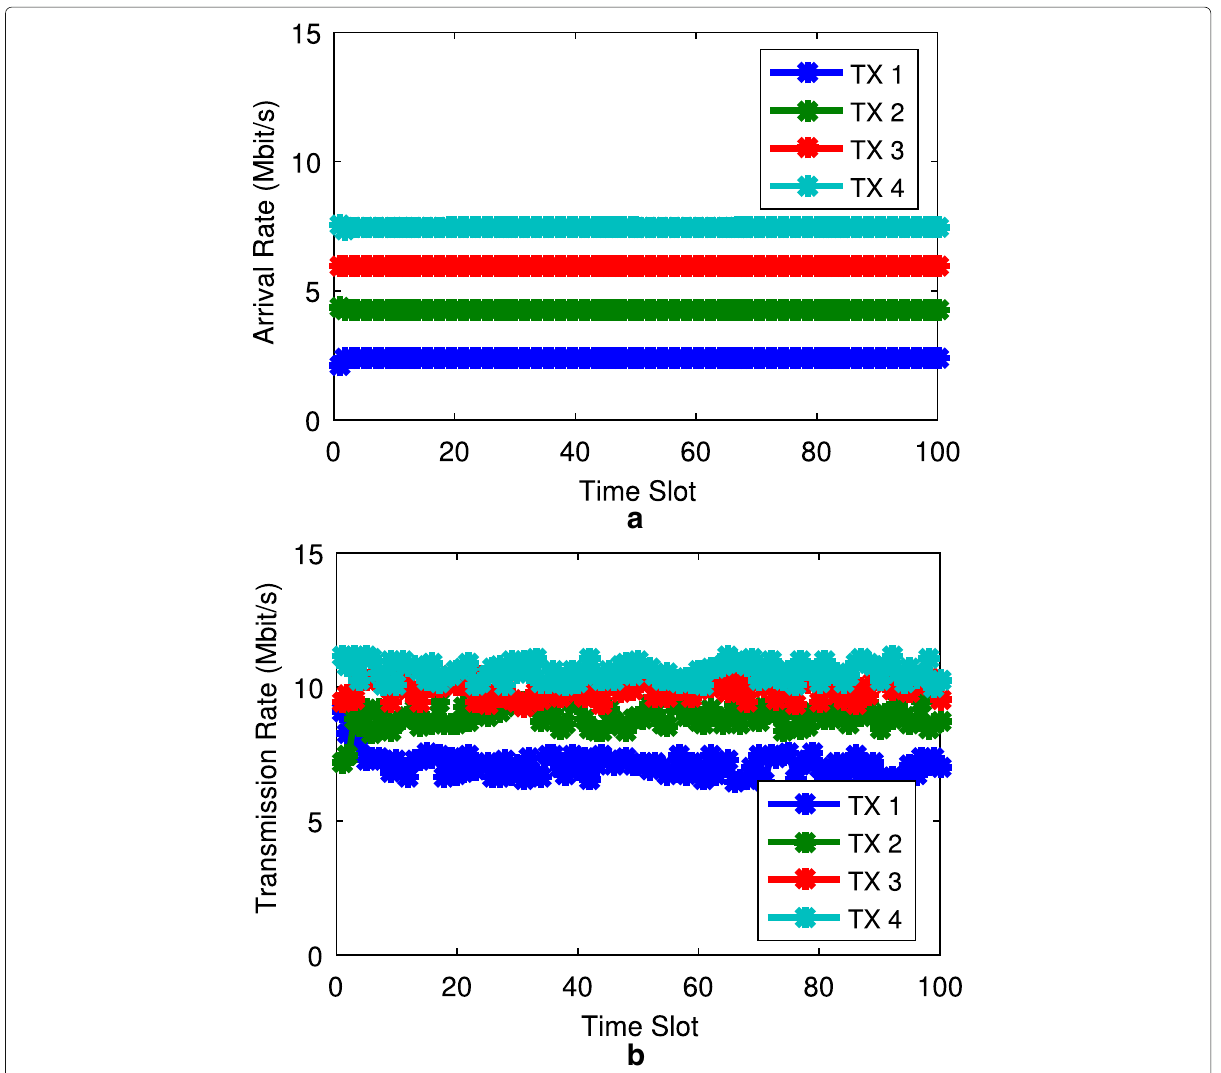
Fig. 3 a , b Rate stability versus time